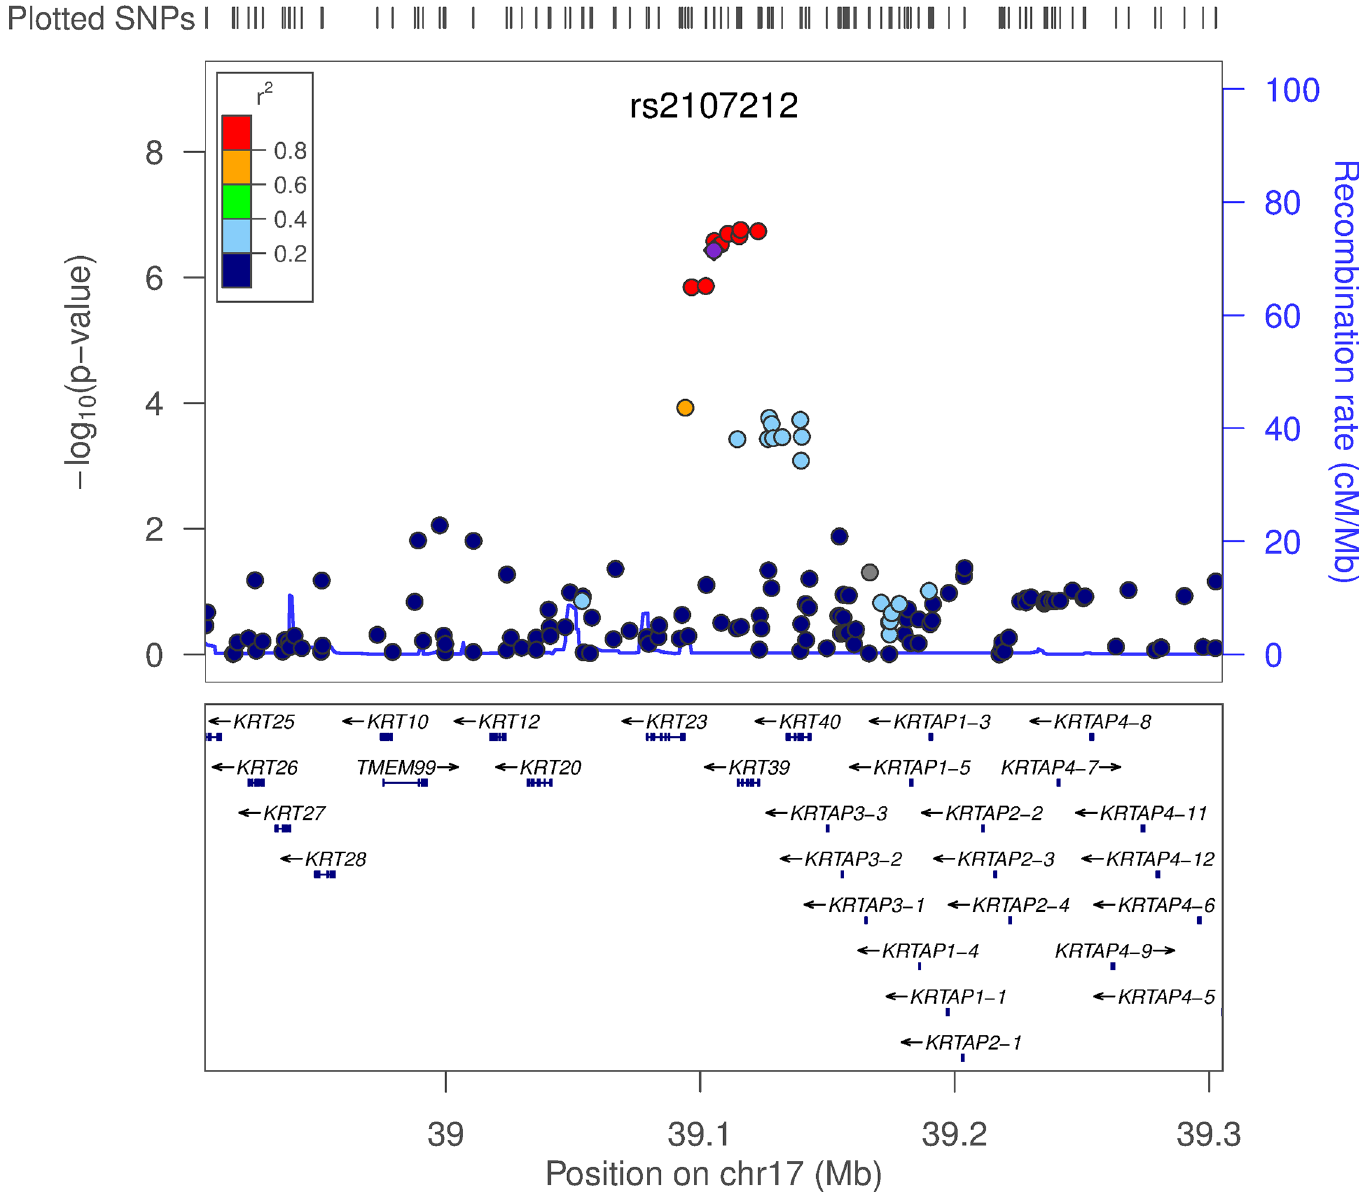
Fig 2. Regional plot showing replicable SNPs in 17q21.2. A regional plot was generated in LocusZoom Version1.1 for the MESA genome-wide interaction analysis results. P-values on the -log10 scale are displayed on the y axis, and chromosome positions are displayed on the x axis. This plot shows the tag SNP (rs2107212) in purple with a 200kb flanking region on each side. The pairwise LD pattern with rs2107212 is also shown. The bottom panel shows the name, position and transcription direction of each gene in this